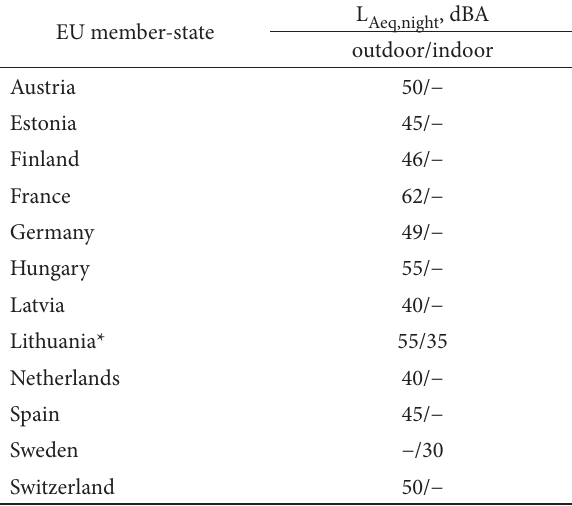
Fig. 1. Speed effects on vehicle noise sources and crossover speed (Rasmussen et al. 2007) Table 1. The highest acceptable values of L Aeq,night indicator for noise from road traffic flow in the newly designed residential areas